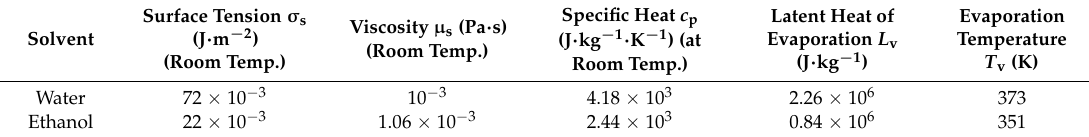
Table 2. Properties of two solvents commonly used in the SPPS